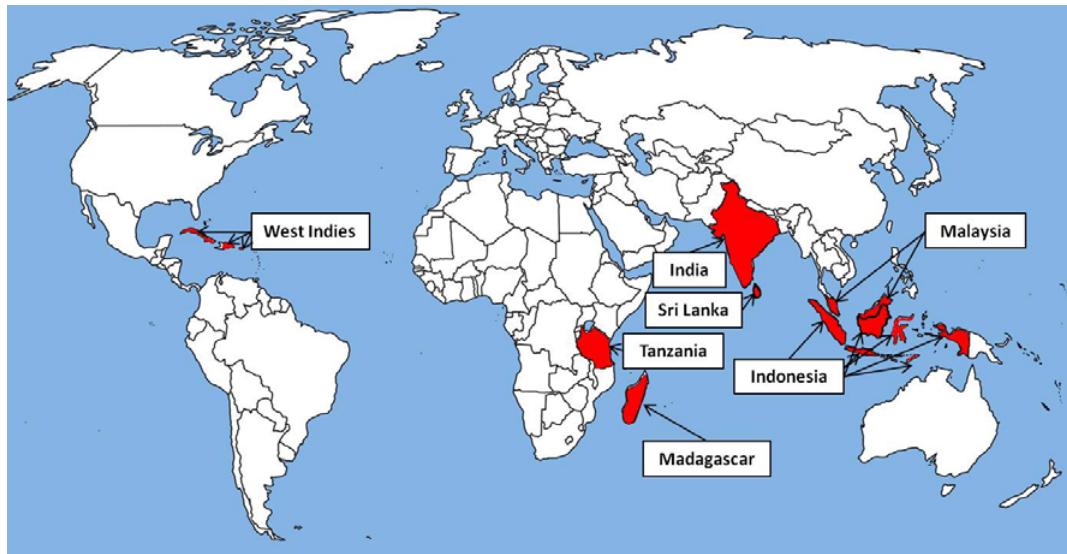
Figure 2. The major clove producers of the world are the West Indies, Madagascar, Tanzania, India, Sri Lanka, Indonesia and